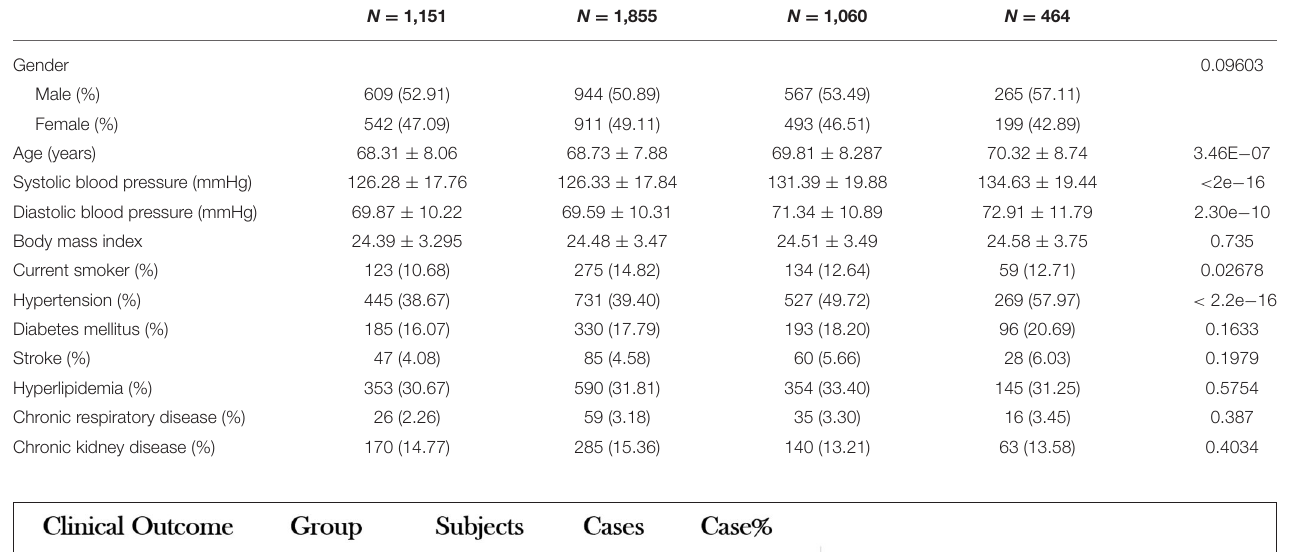
TABLE 2 | Demographic characteristics of study subjects ( N = 4,530) divided into subgroups based on number of ECG abnormal parameters (0, 1, 2, ≥ 3). ECG